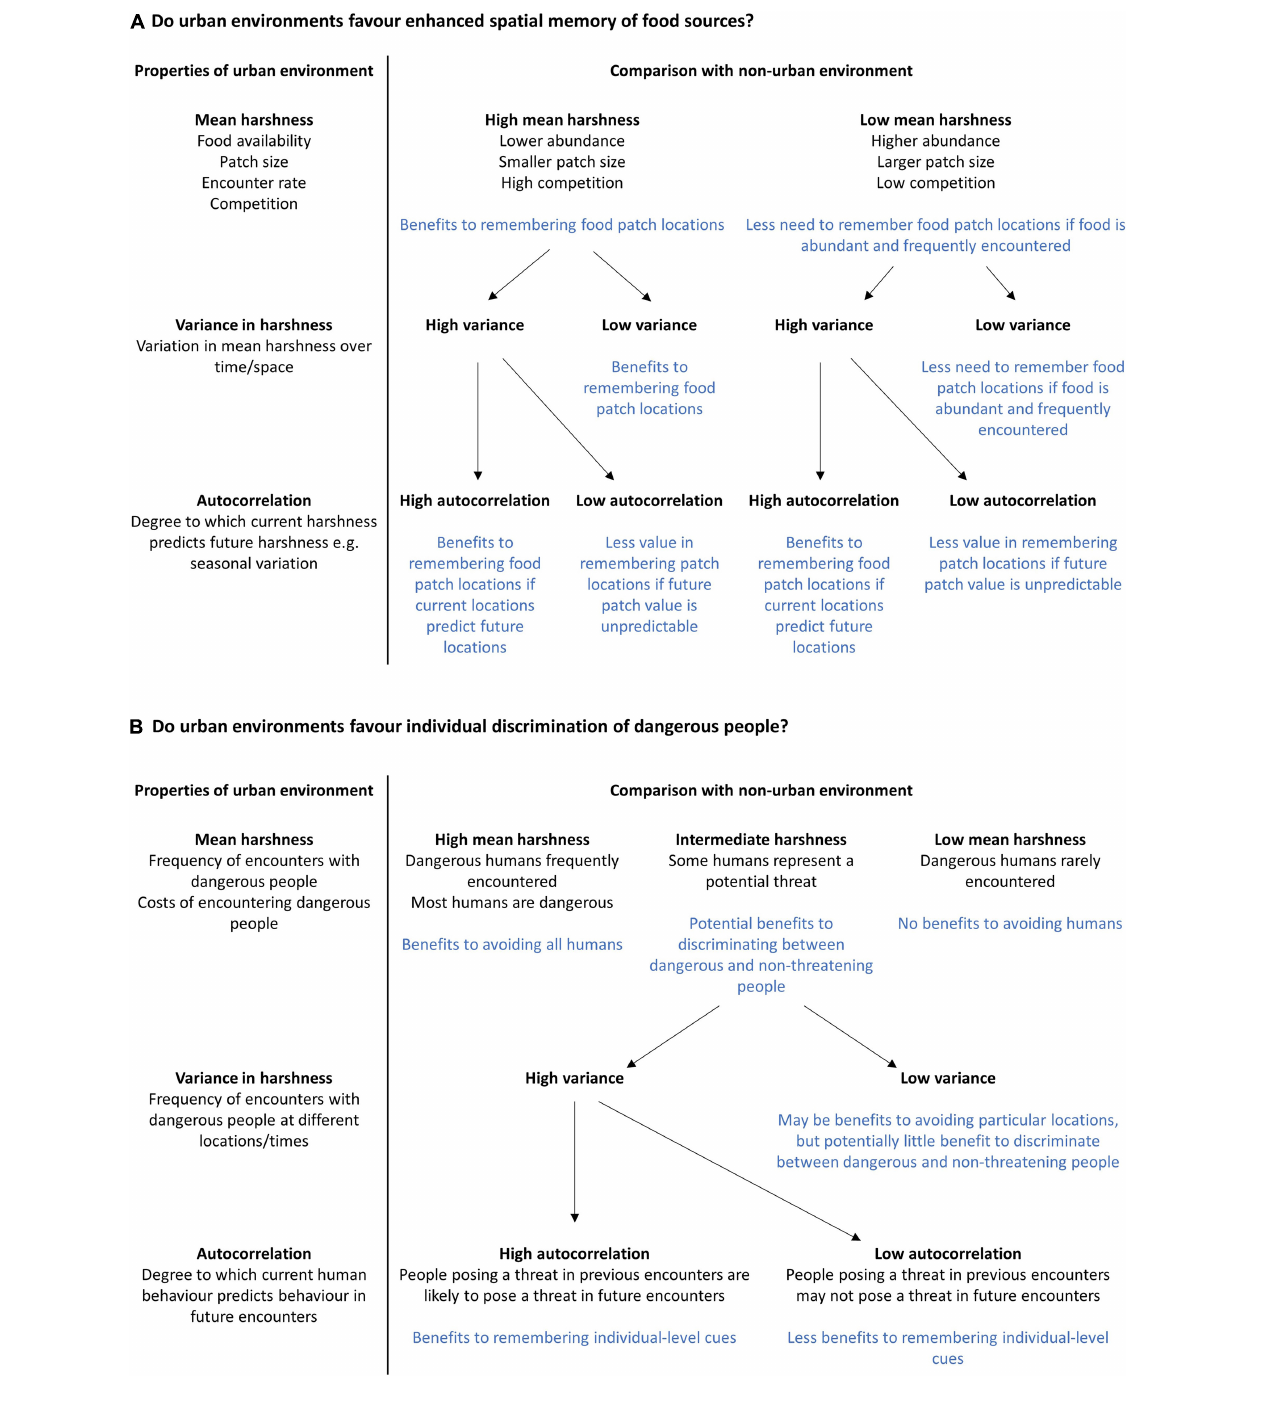
FIGURE 1 | Two examples of how information on the statistical properties of the urban environment may be used to formulate hypotheses and predictions regarding the importance of cognitive processes in allowing wildlife to cope with the challenges of city life. (A) Do urban environments favour enhanced spatial memory of food sources? (B) Do urban environments favour individual discrimination of dangerous people?